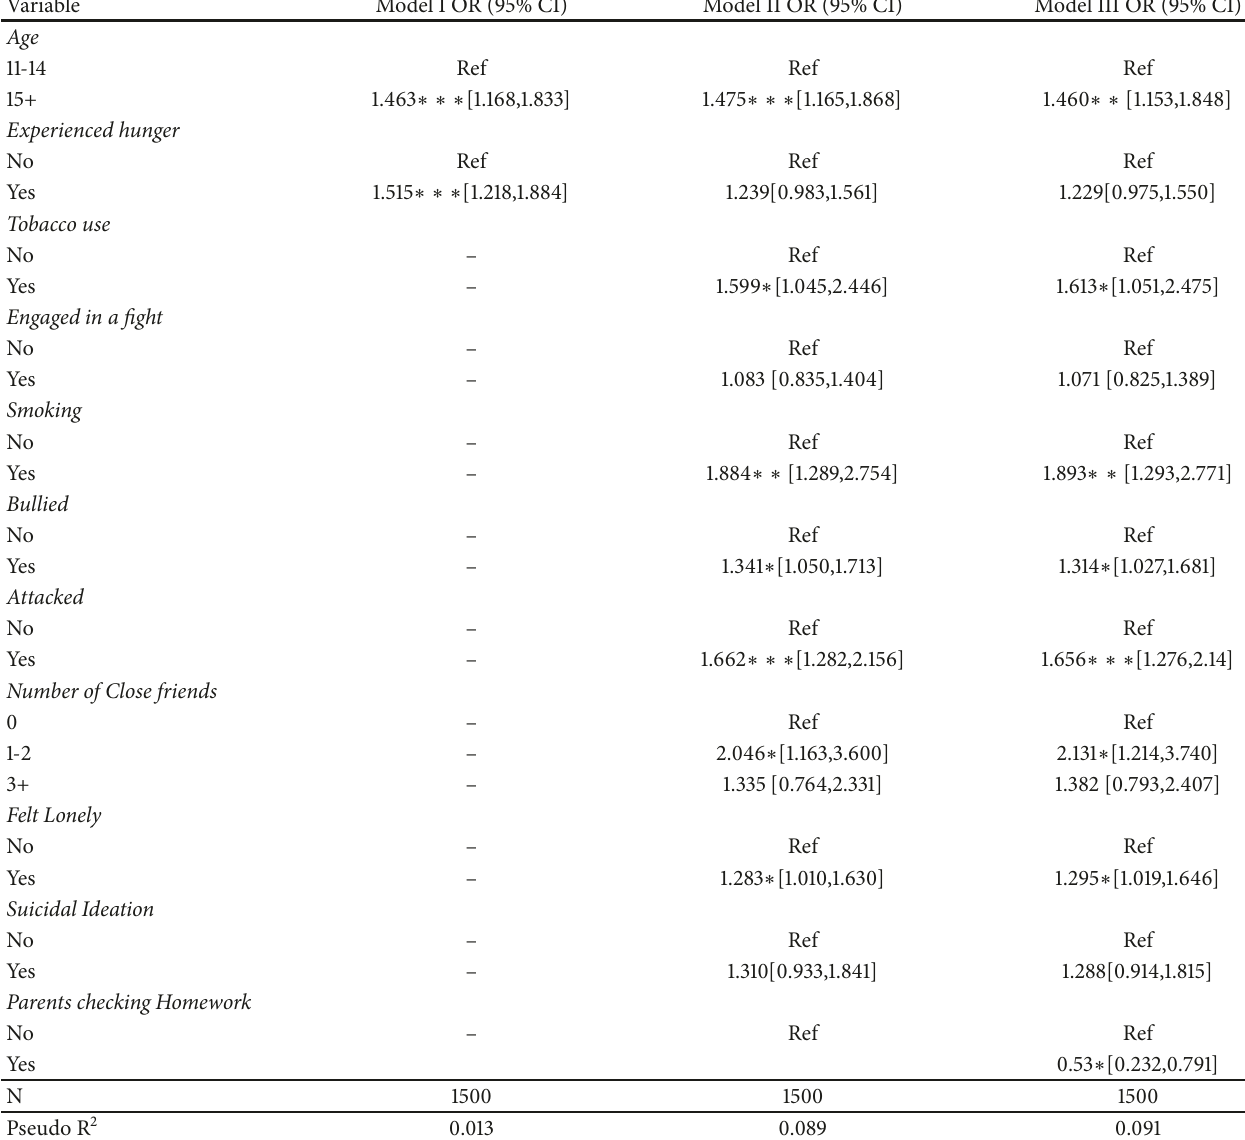
Table 3: Multivariate analysis on the association between independent variables and